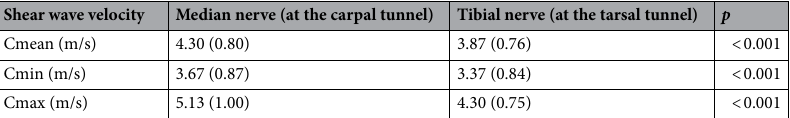
Table 4. Comparison of shear wave velocities of different peripheral nerves.